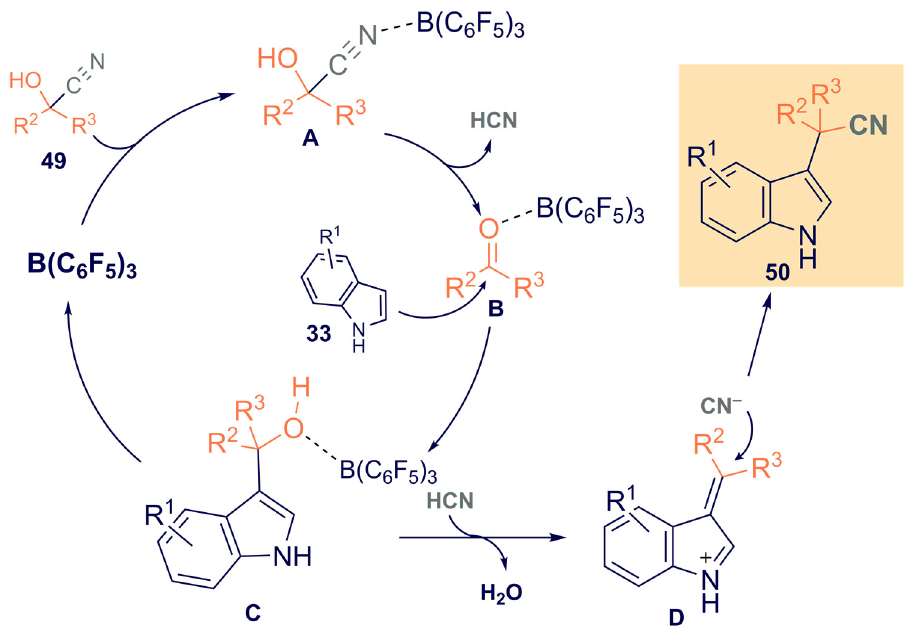
Scheme 17. Reaction mechanism proposed for the BCF-catalyzed cyanoalkylation reaction of in-